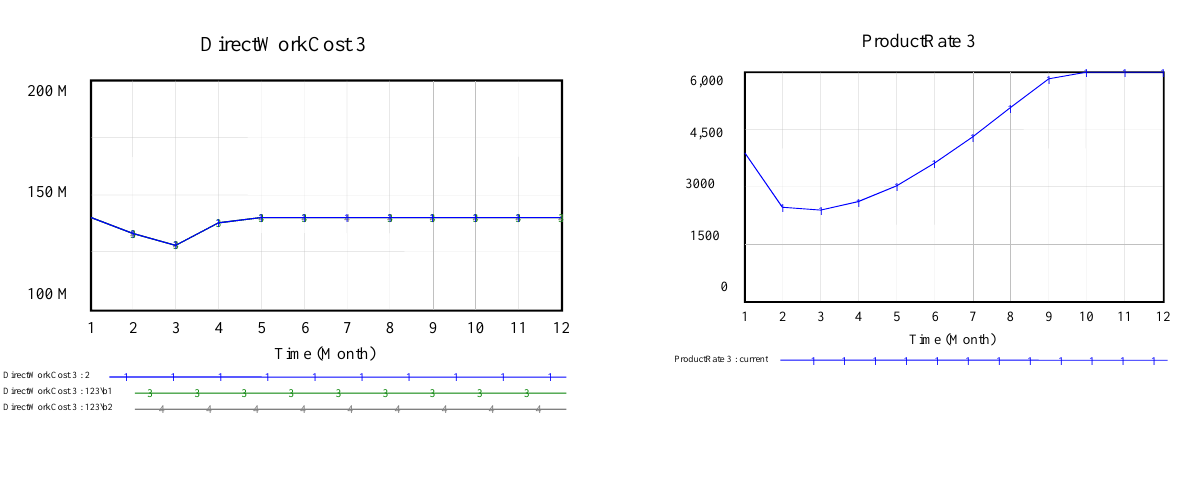
Fig. 3. The production rate as well as direct work